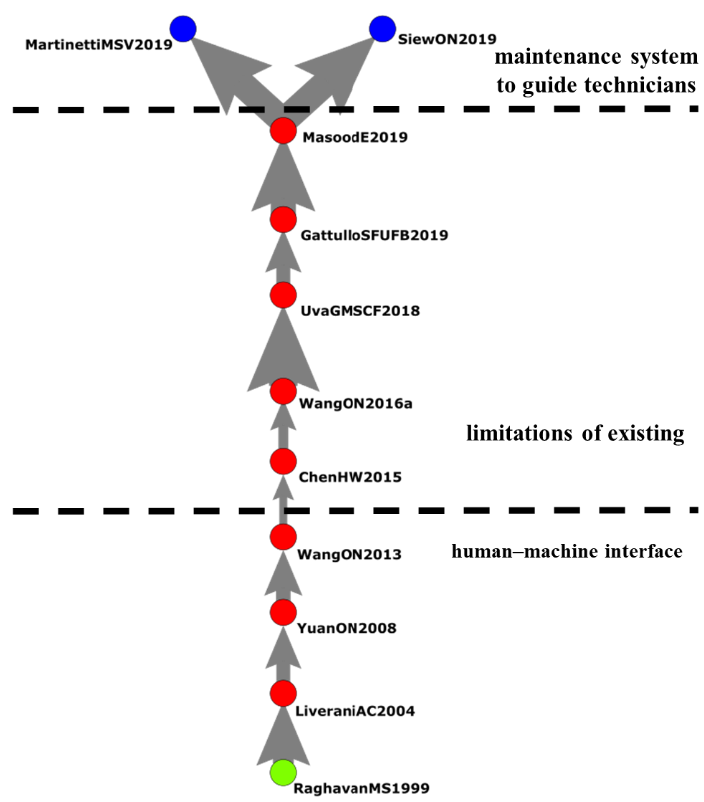
Figure 8. Application of AR technology in manufacturing.